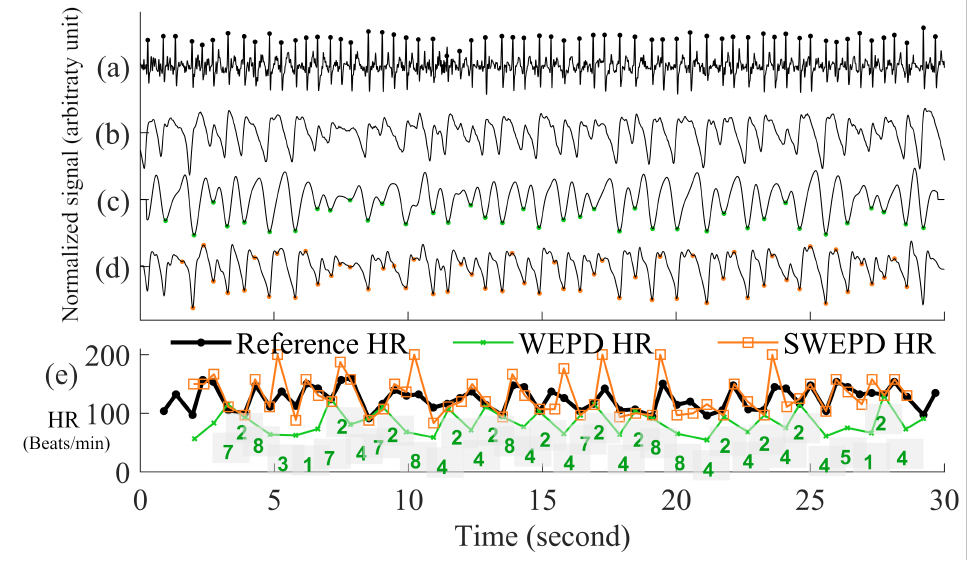
Figure 6. Representative example of peak correction for AF with RVR. Top panel ( a ) is the reference ECG; panel ( b ) is a raw PPG signal; panel ( c ) is the peak detection output from WEPD; panel ( d ) is the peak correction (SWEPD) for fast heart rate AF with corrected heartbeats. The bottom panel ( e ) is the heart rate (unit: BPM) comparison with the reference heart rates, estimated heart rates from SWEPD and peak corrections of fast heart rate AF. Region information for each heartbeat of WEPD is labeled on the heart rate in the bottom panel ( e